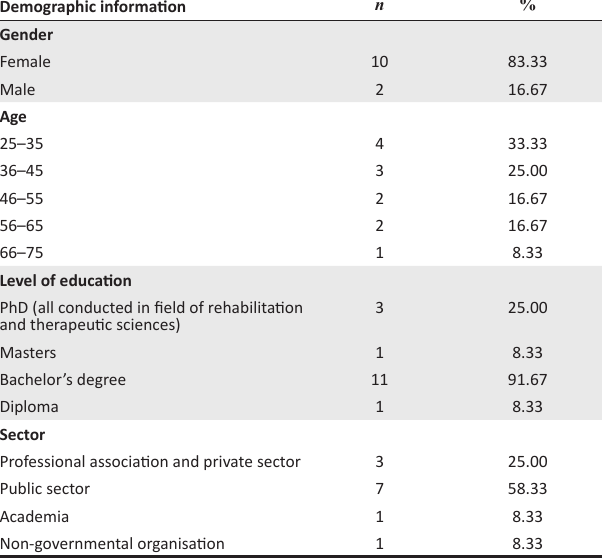
TABLE 1: Demographic information of key informants. Demographic